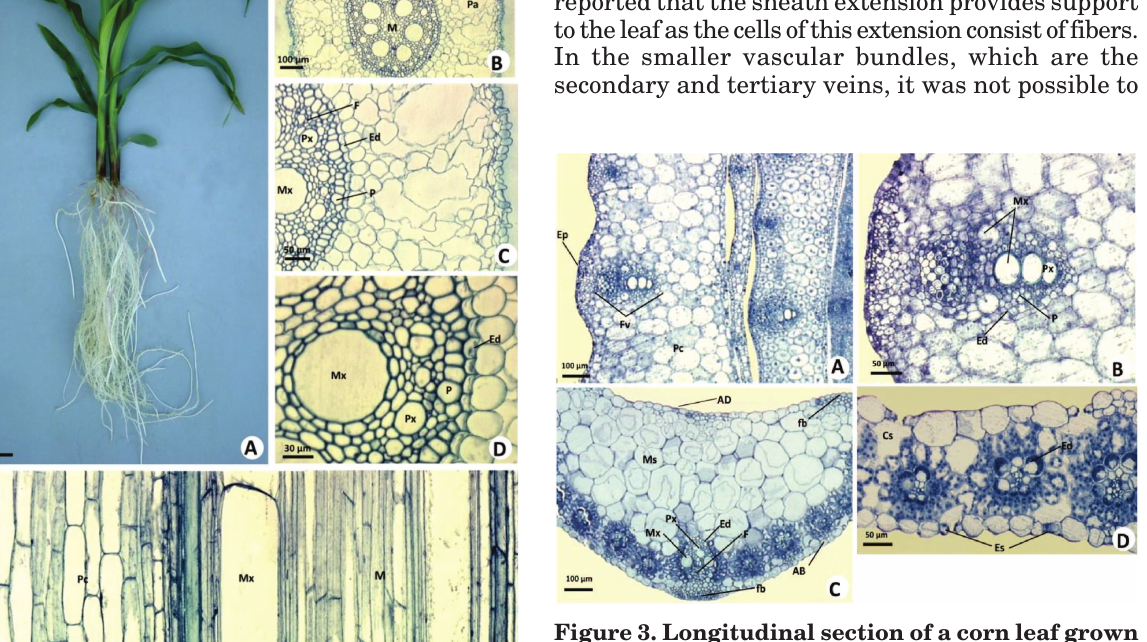
Figure 3. Longitudinal section of a corn leaf grown in nutrient solution without addition of aluminum. a) Sheaths of the stem median region. b) Detail of the external sheath vascular bundle. c) Median region of the limbo with the midrib. d) Detail of the vascular bundles